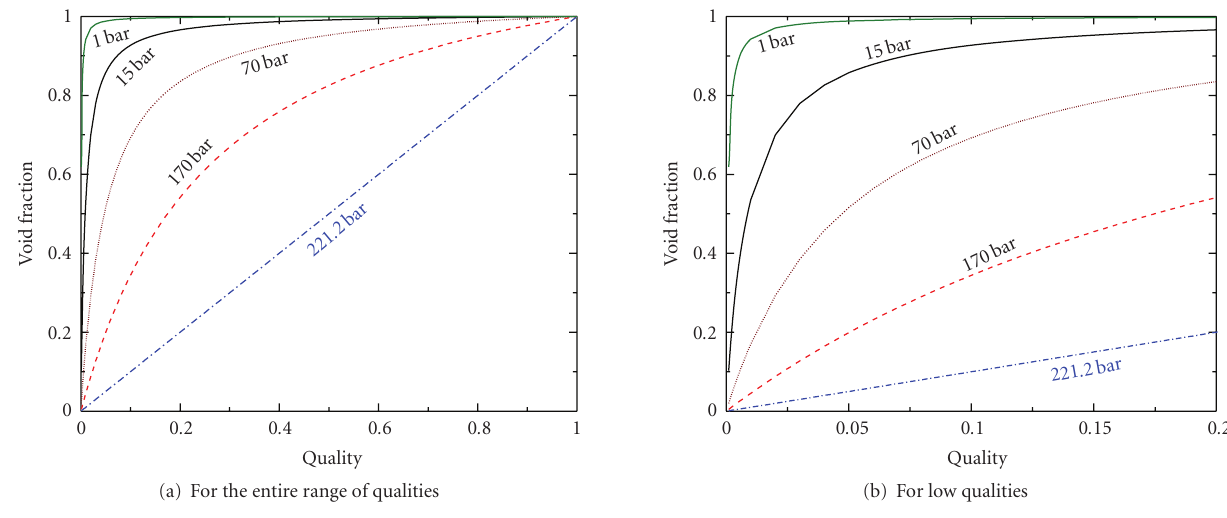
Figure 6: E ff ect of pressure on the void